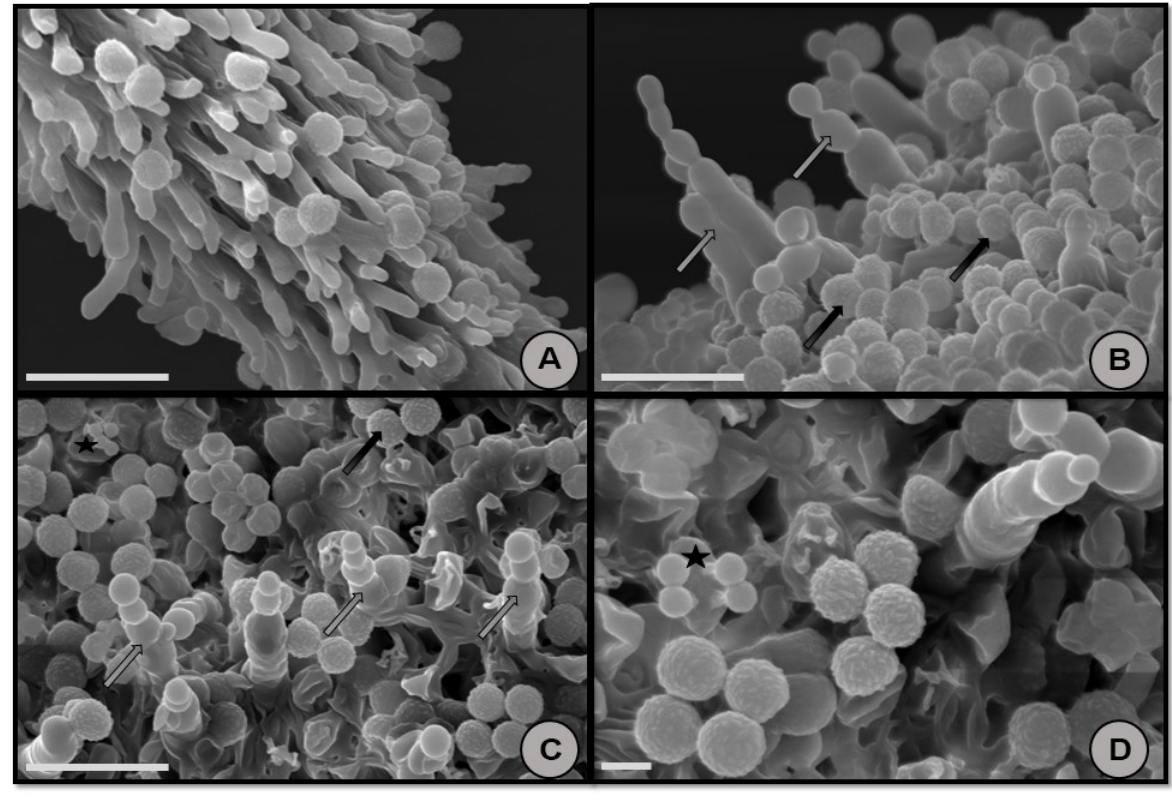
Fig. 3 Scanning electron micrographs of Hericium flagellum . ( A ) Ending of the spine; ( B–D ) gloeocystidia (white arrows) and basidiospores (black arrows); star – basidium with immature basidiospores. Scale: ( A ) 10 µm; ( B ) 2 µm; ( C ) 10 µm; ( D ) 10 µm. Photographs: M. Bihun and B.